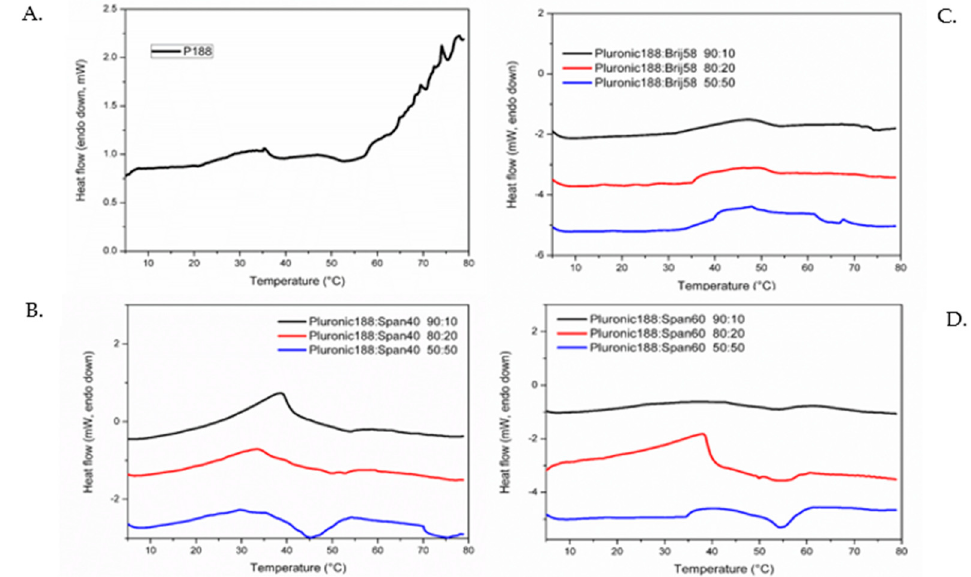
Figure 3. microDSC thermograms for ( A ) Poloxamer 188 (10 mg/mL), ( B ) Poloxamer 188-Span 40 ® , ( C ) Poloxamer 188-Brij 58 ® , and ( D ) Poloxamer 188-Span 60 ® at different weight ratios.